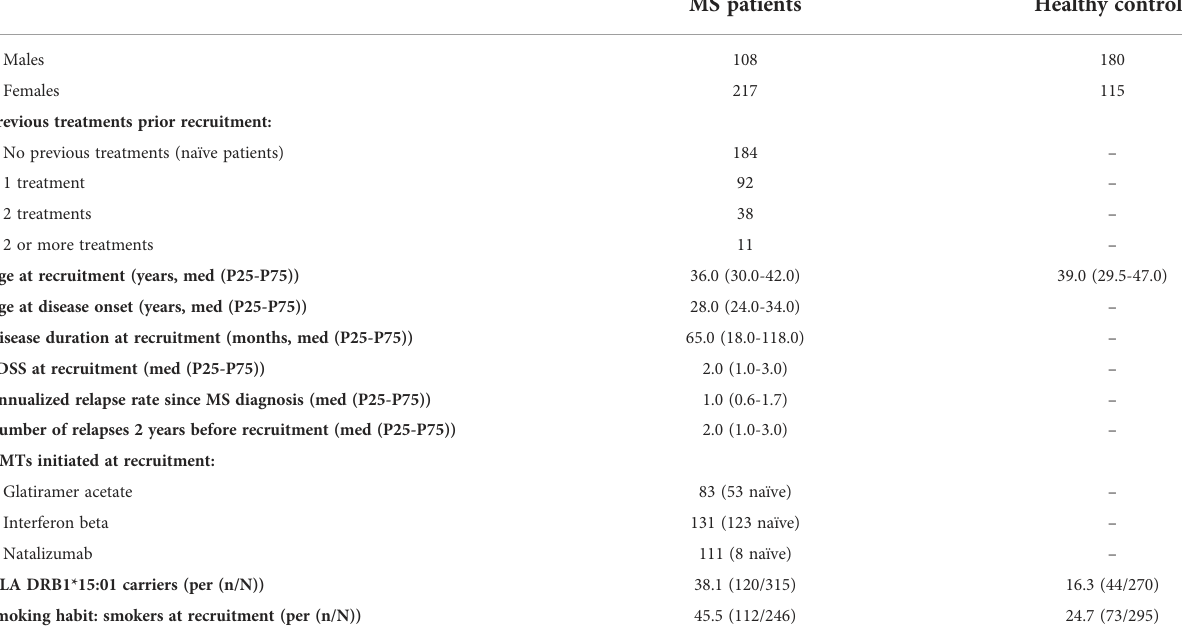
TABLE 1 Demographical characteristics of the patients and healthy controls included in the study at the